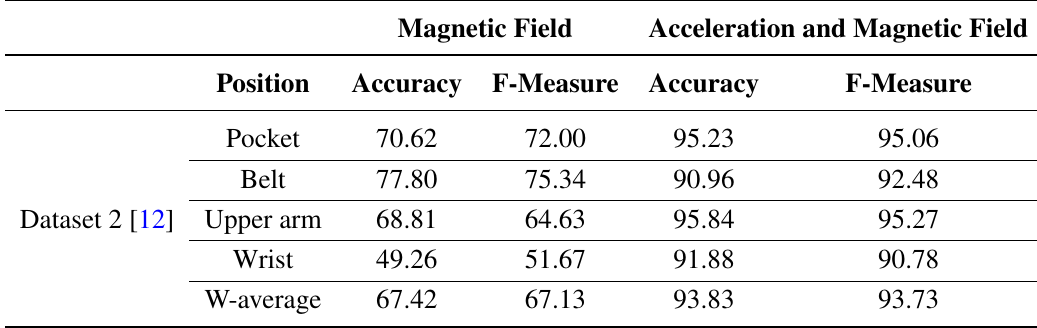
Table 8. Results with magnetic field and acceleration